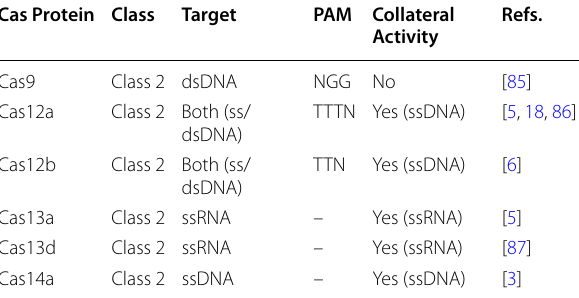
Table 1 Salient features of various Cas proteins used